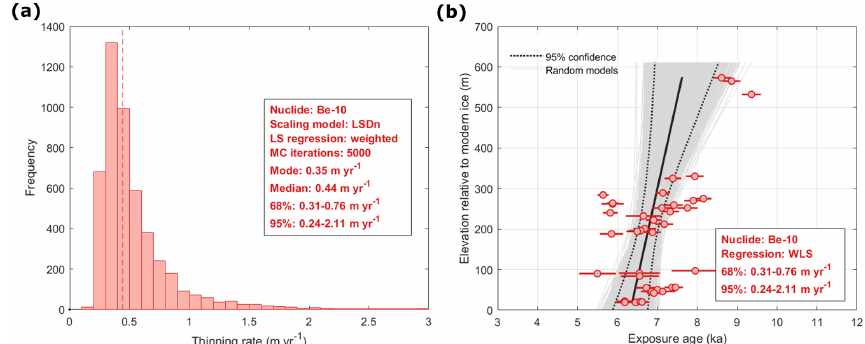
Figure C2. Results for sensitivity test of linear regression analysis. (a) Histogram showing thinning rate output and (b) linear regression analysis generated by iceTEA (Jones et al., 2019) used to calculate timing and rate of ice sheet thinning. The relative elevations (vertical distance above ice surface elevation) were calculated using outcrop-specific ice surface elevations for outcrop A and outcrop B rather than the original measured representative ice surface elevation (80ma.s.l.) that was used to model our preferred thinning history (main text, Fig. 6, Fig.